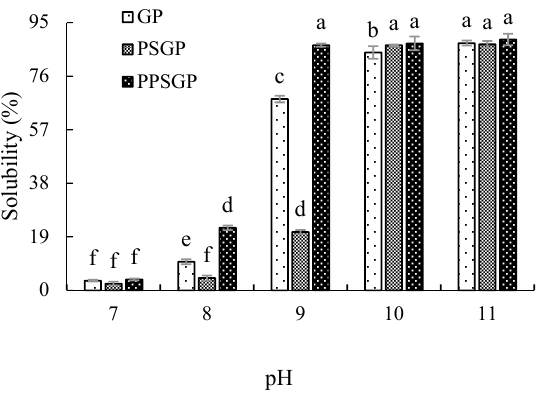
Figure 1. Protein solubility of GP, PSGP, and PPSGP. Different letters indicate significant differ- ences.